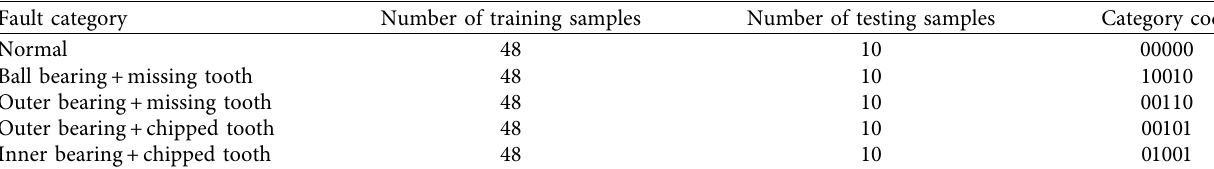
Figure 8: Five types of gears. Table 4: Samples and